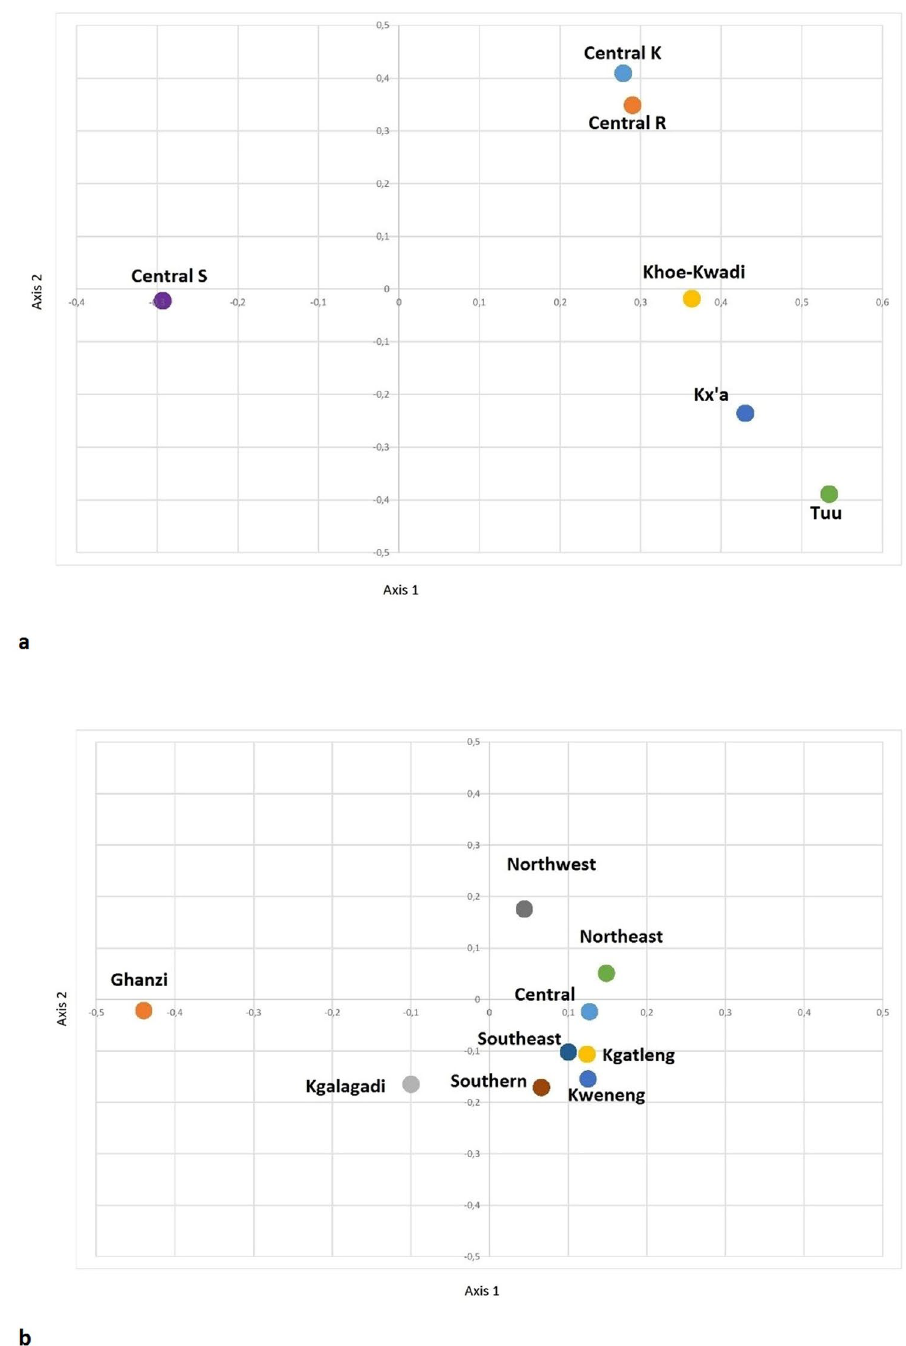
Figure 2. ( a ) Factorial correspondence analysis (FCA) of the language subgroups of the Bantu (Central-K, -R and -S) and Khoisan (Tuu, Kx’a, and Khoe-Kwadi) speaking people of Botswana. ( b) Factorial correspondence analysis (FCA) of the nine administrative districts of